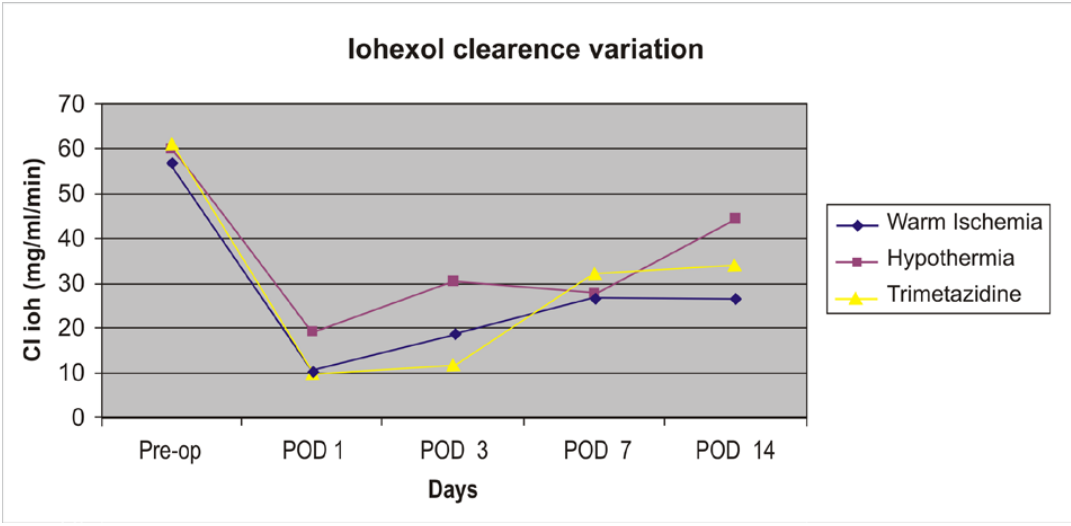
Figure 2. Decrease of iohexol clearance on POD1 and POD2 with stabilization of the renal function on